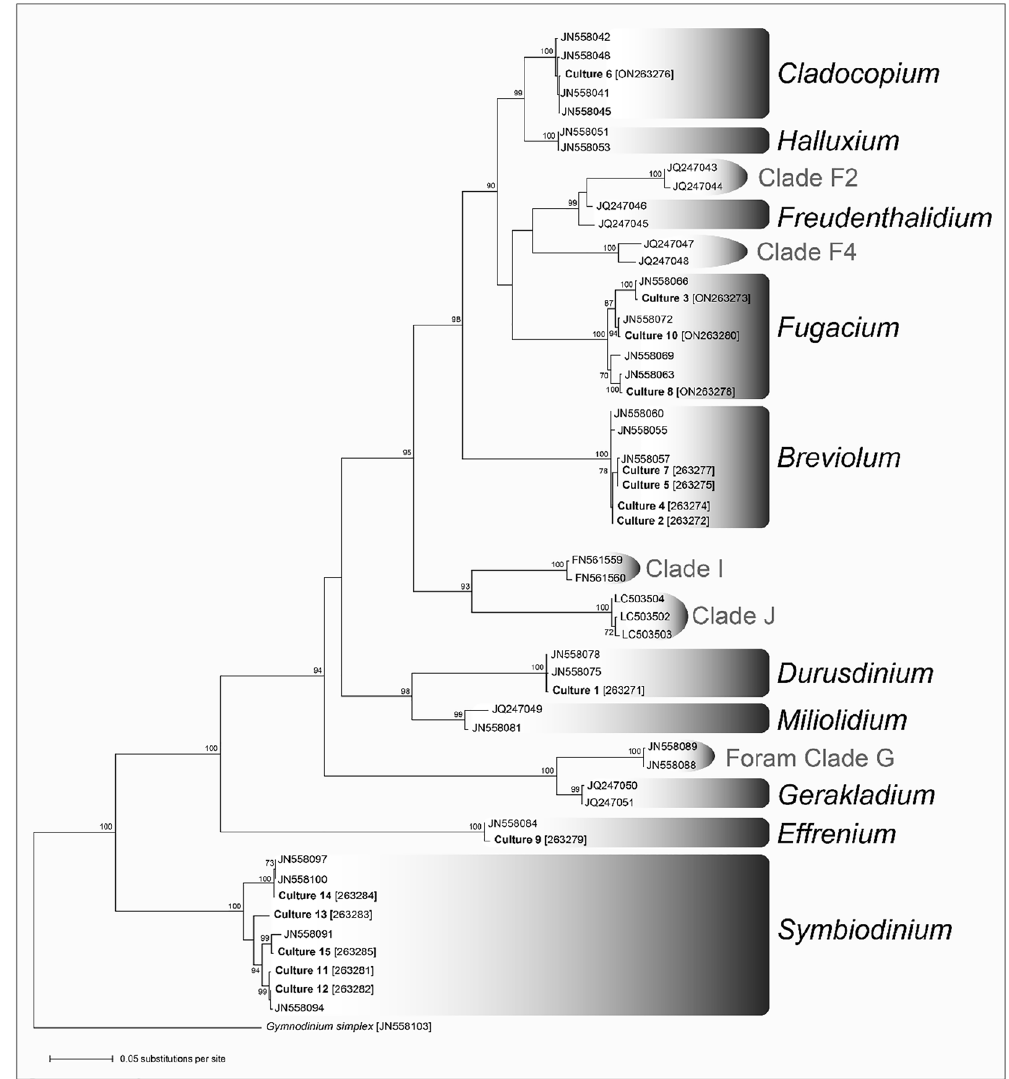
Figure 1. Best Maximum likelihood (ML) topology for the family Symbiodiniaceae based on nuclear large subunit ribosomal 28S rRNA gene, showing the phylogenetic placement of the 15 putative culture isolates (Cultures 1–15 in bold) together with their GenBank accession numbers as provided in Table 1 among the Symbiodiniaceae genera. Numbers at nodes represent the ML bootstrap pseudoreplicate (BP) values, excluding BP values lower than 70%. The phylogram was rooted using the dinoflagellate Gymnodinium simplex